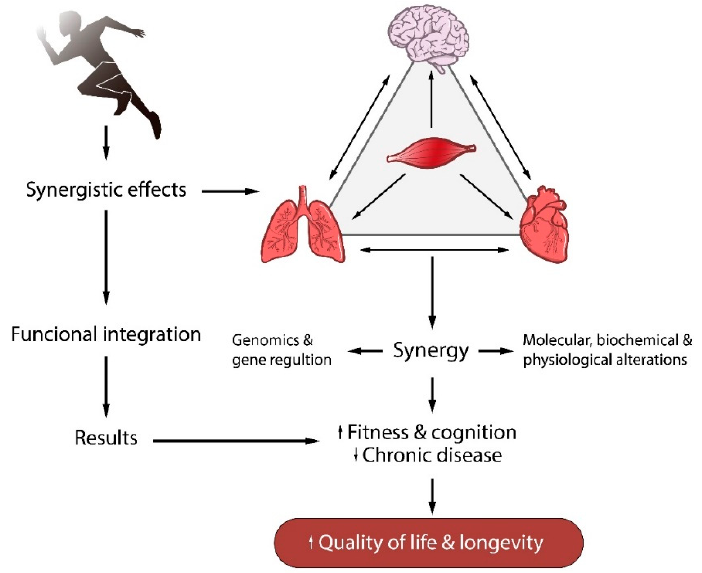
Figure 1. Interactions between bodily systems from regular physical exercise. A synergistic effect between muscle, brain, and heart which modulates molecular, biochemical, and physiological changes, decreasing the risk of chronic diseases.